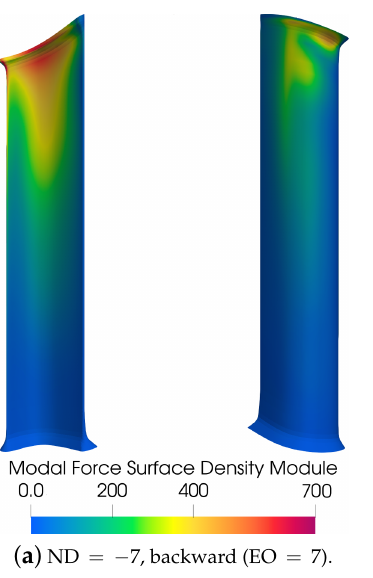
Figure 16. Modal force surface density